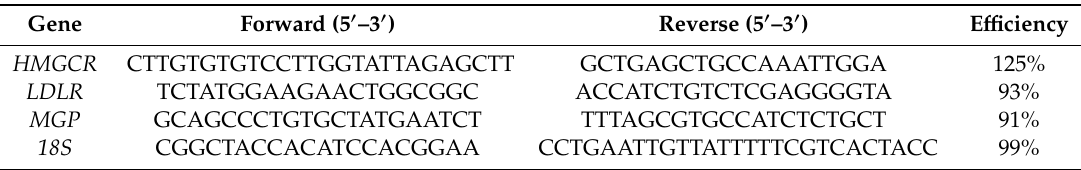
Table 1. Primer sequence utilized for the qPCR